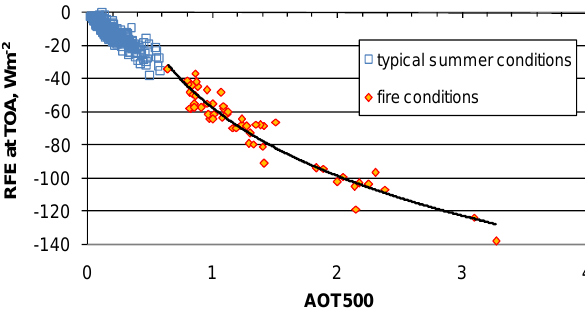
Fig. 12. Radiative forcing effects (RFE) at the top of the atmosphere Fig.12. Radiative forcing effects (RFE) at the top of the atmosphere (TOA) as a (TOA) as a function of AOT500 in typical conditions (for July– function of AOT500 in typical conditions (for July-August period) and during fire August period) and during the fire events 2002 and events 2002 and 2010.